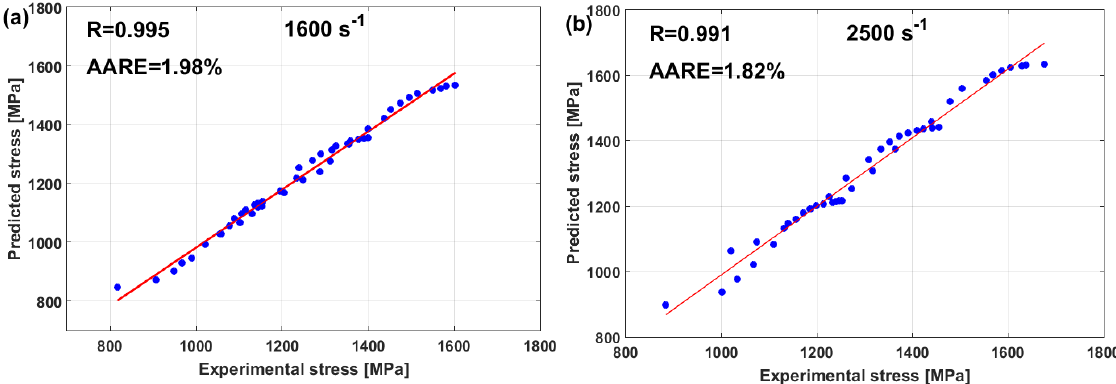
Figure 18. Correlation of experimental stresses and predicted stresses obtained by the modified JC model that was presented by Shin and Kim [75] for tungsten heavy alloy at 298 K, 773 K, and 1173 K for ( a ) 1600 s −1 and ( b ) 2500 s −1 .